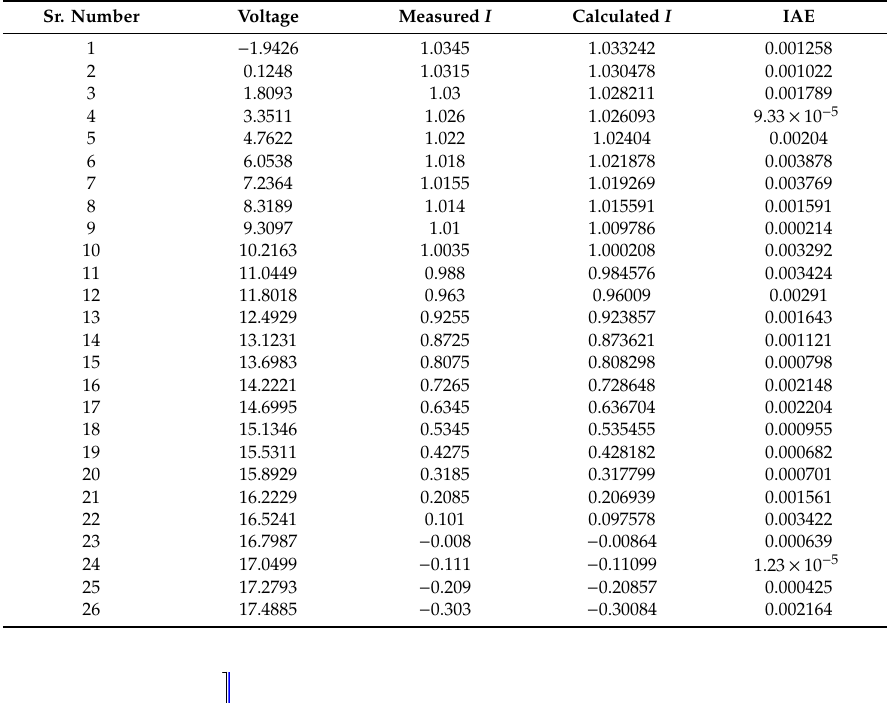
Figure 14. P–V curve obtained from the calculated current for the double-diode module.